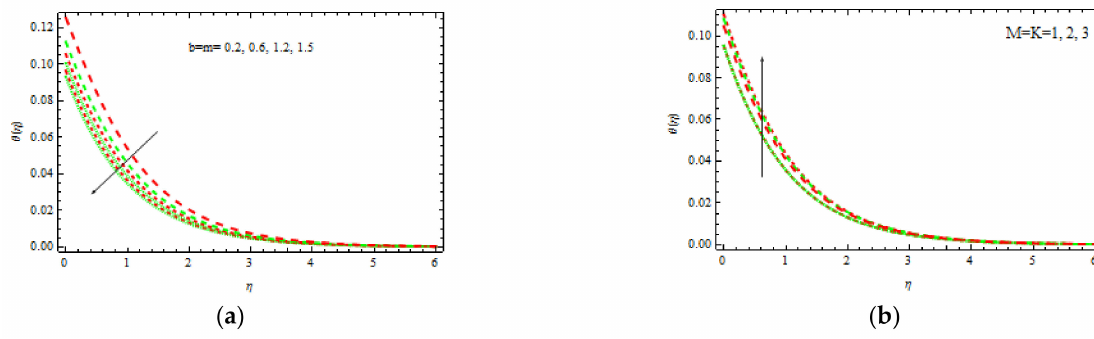
Figure 7. Inspiration of b , m ( a ) and M , K ( b ) on temperature.